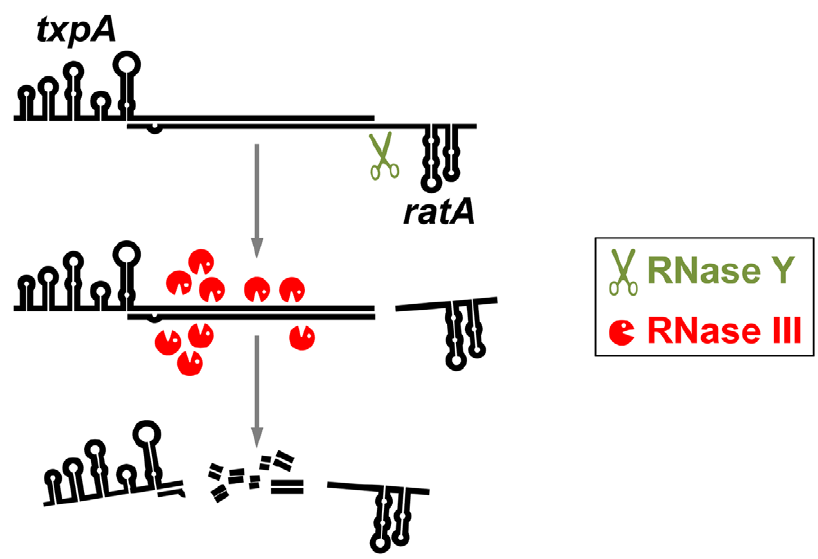
Figure 1. Degradation of a phage-encoded toxin mRNA in B.subtilis . The toxin-encoding mRNA txpA is degraded by the combined action of the antisense RNA ratA and the double strand–specific endonuclease RNase III. The txpA–ratA RNA hybrid may be destabilized due to prior processing by the essential RNase